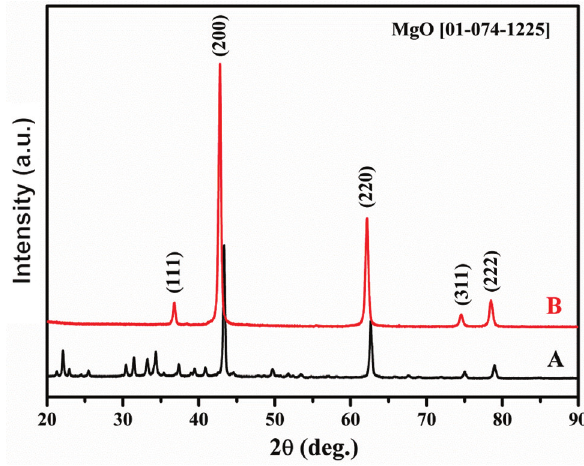
Figure 3 Typical X-ray diffraction (XRD) patterns of the products obtained by thermal plasma process: (A) before treatment with feeding rate of 1.50 ml/min; and (B) its corresponding product after posttreatment. (The numbers after the phases are the JCPDS file numbers.)